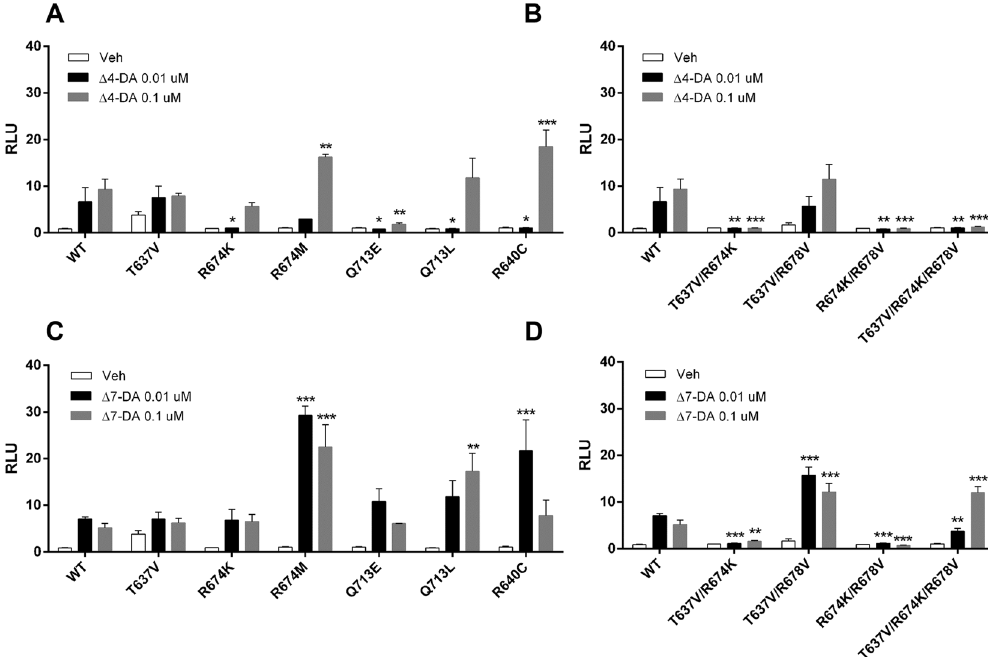
Figure 5. Mutation of residues in DimDAF-12 ligand binding pocket abolishes the activity of the receptor. NIH3T3 cells were co-transfected with wild type Gal4-DimDAF-12_LBD or the corresponding mutants and luciferase gene reporter construct and then tested with 0.01 or 0.1 uM of Δ4- ( A single mutant, B double mutants) or Δ7- ( C single mutant, D double mutants) dafachronic acids (DAs). The ligand binding and transactivation activity were assessed by measuring the luciferase activity, normalized by Renilla luciferase activity for transfection efficiency and expressed as relative light units (RLU). Data represent the average of normalized luciferase activity and the error bars correspond to the standard error of the mean from a triplicate assay. The figure shows a representative experiment performed in triplicate. The significance of the effects of mutation on DimDAF-12 LBD activity was analyzed by two-way ANOVA with multiple comparisons without correction using Prism 6.0 (Graph Pad Software, Inc.) (*** p < 0.0005; ** p < 0.005; * p < 0.05) versus